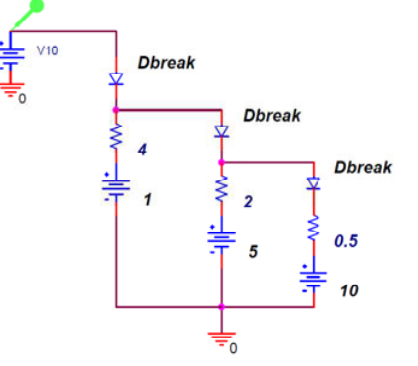
Figure 15: Resistor behavior of the “S” switch model between two defined thresholds